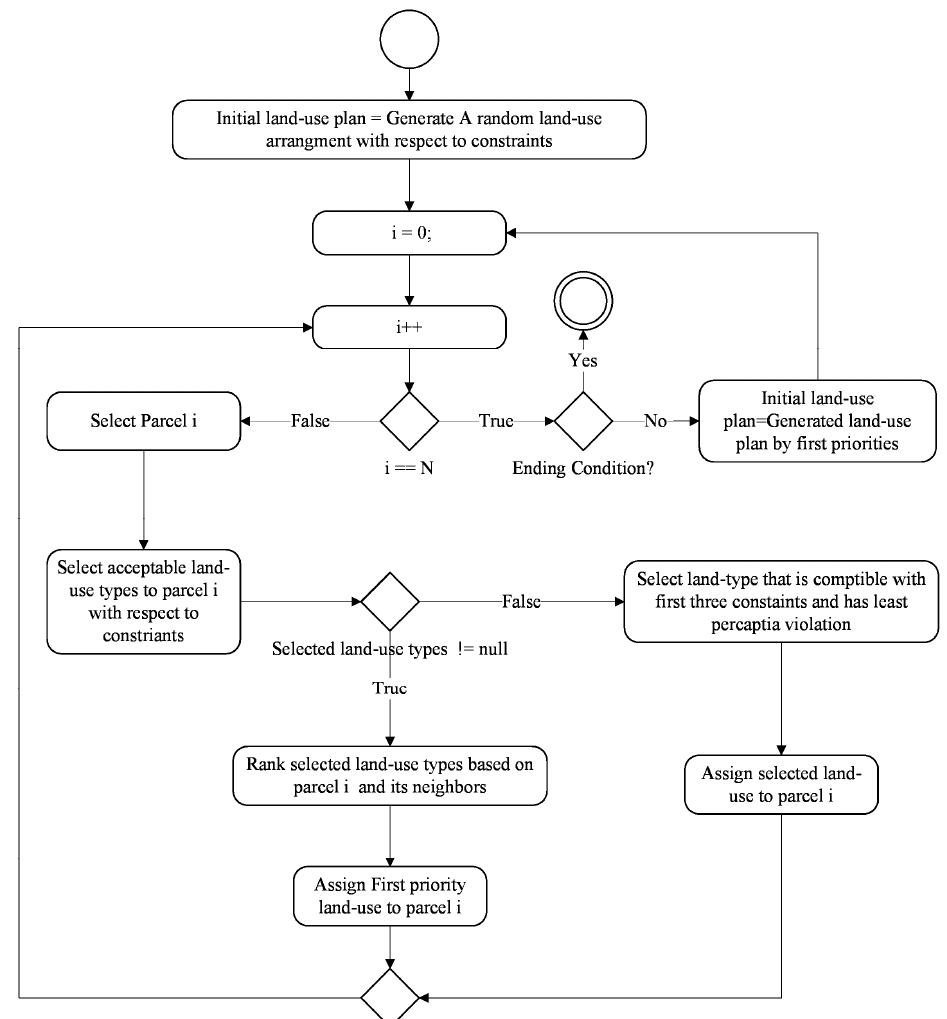
Figure 3. Land-use allocation process.